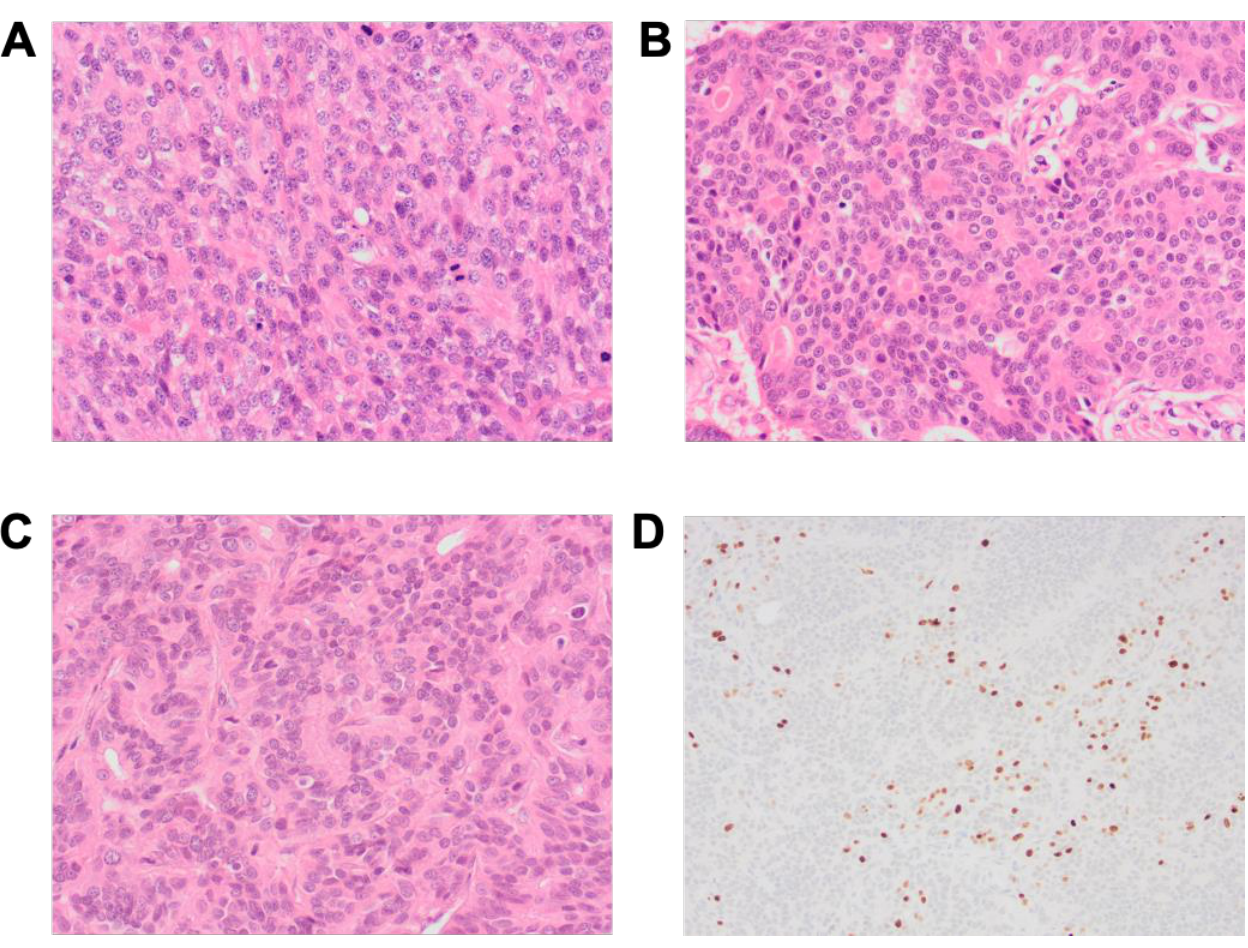
Figure 4. Selected histopathological features of AGASAC lesions. ( A ) Solid pattern: densely packed sheets of neoplastic epithelial cells and a minimal amount of fibrovascular stroma. ( B ). Rosette pattern: neoplastic epithelial cells radially arranged around a small amount of eosinophilic secretion. ( C ). Tubular pattern: neoplastic cells form tubular structures. ( A – C ). Haematoxylin and eosin stain magnification ×400. ( D ). Ki67 immunolabelling, Ki67% 54.7, magnification ×200.